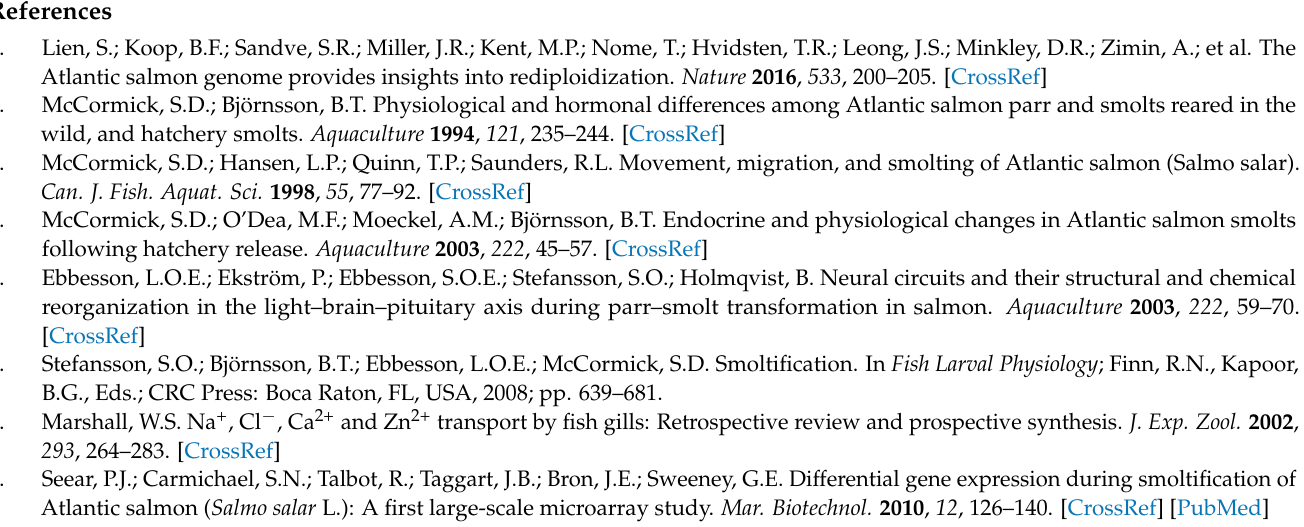
Na+/K+-ATPase positive cells are indicated with black arrows. Magnification 60 × . Figure S3. RT- qPCR analysis of ATPase- α and ATPase- β subunits in Atlantic salmon gills exposed to GSC and SS. Significant differences between experimental conditions are indicate with asterisk ( p < 0.05). Figure S4. Heatmap representation of Atlantic salmon transcriptome for gills, intestine and head kidney tissues exposed GSC and SS conditions. Red and blue colors represent the gene expression levels from high to low transcription values. Figure S5. Cluster gene expression analysis of transposable elements (TEs) during SW transfer in Atlantic salmon gills. ( A ) Expression values of TE transcripts in Atlantic salmon gradually transferred from FW to SW (GSC) and from FW to salinity shock (SS), respectively. The four gene clusters were detected by K-means algorithm using TPM values. ( B ) RT-qPCR validation for transposable elements Tcb1 and Tcb2 for GSC and SS, respectively. For GSC Atlantic salmon group T1, T2, and T3 correspond a week after salmons were at 10, 20, and 32 PSU, respectively. For the SS group, the T1 and T2 are 2 and 3 weeks before salinity shock, and T3 is a week after salinity shock (32 PSU). Elongation factor was used as endogenous control for normalize data. Figure S6. Cluster gene expression analysis of miRNAs during SW transfer in Atlantic salmon gills. ( A ) Expression values of TE transcripts in Atlantic salmon gradually transferred from FW to SW (GSC) and from FW to salinity shock (SS), respectively. The four gene clusters were detected by K-means algorithm using TPM values. ( B ) RT-qPCR validation for ssa-miR-143, ssa-miR-21b, ssa-miR-10d expressed in response to GSC, and ssa-miR-181, ssa-miR-10b and ssa-miR-30d expressed in gills samples exposed to SS. For GSC Atlantic salmon group T1, T2, and T3 correspond a week after salmons were at 10, 20, and 32 PSU, respectively. For the SS group, the T1 and T2 are 2 and 3 weeks before salinity shock, and T3 is a week after salinity shock (32 PSU). Ssa-mir-455-5p was used as endogenous control for normalize data. Figure S7. RT-qPCR validation of candidate miRNAs and their putative target gene. Fold-changes (Log2) of gene expression were calculated using the FW condition as control group. Elongation factor and Ssa-mir-455-5p were used as endogenous control for mRNAs and miRNAs, respectively. Table S1. chr clusters. Table S2. DEG transcripts annotation. Table S3. miRNA prediction. Table S4. Primer